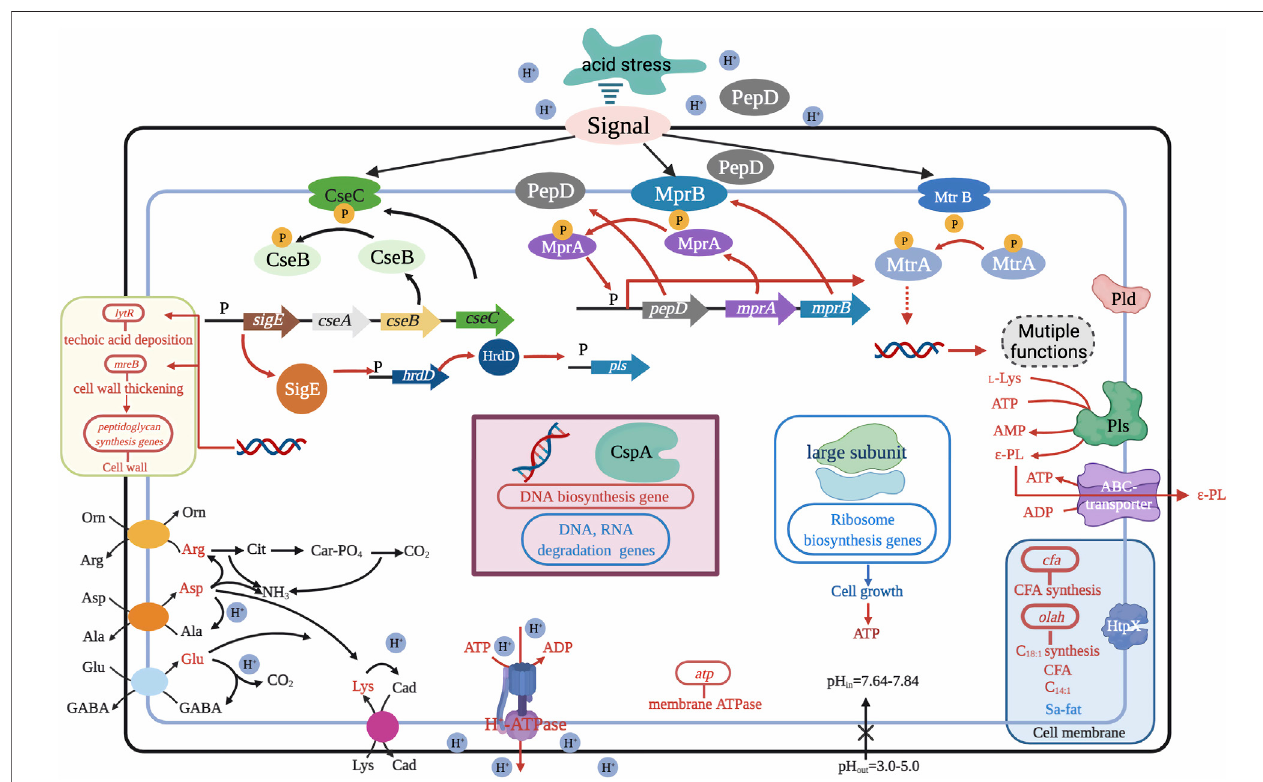
FIGURE 4 | Possible mechanism for the acid tolerance response by S. albulus M-Z18. Figure modi fi ed from Wang C. et al. (2020). Arg, arginine; Asp, aspartate; L-Lys,L-lysine;C 18:1 ,oleicacid;Orn,ornithine;Ala,alanine;Cad,cadaverine;C 14:1 ,myristoleicacid;Cit,citrulline;Glu,glutamate; ε -PL, ε -Poly-L-lysine;Sa-fat,saturated fatty acid; Car-PO 4 , carbamoyl phosphate; GABA, γ -aminobutyrate; CFA, cyclopropane fatty